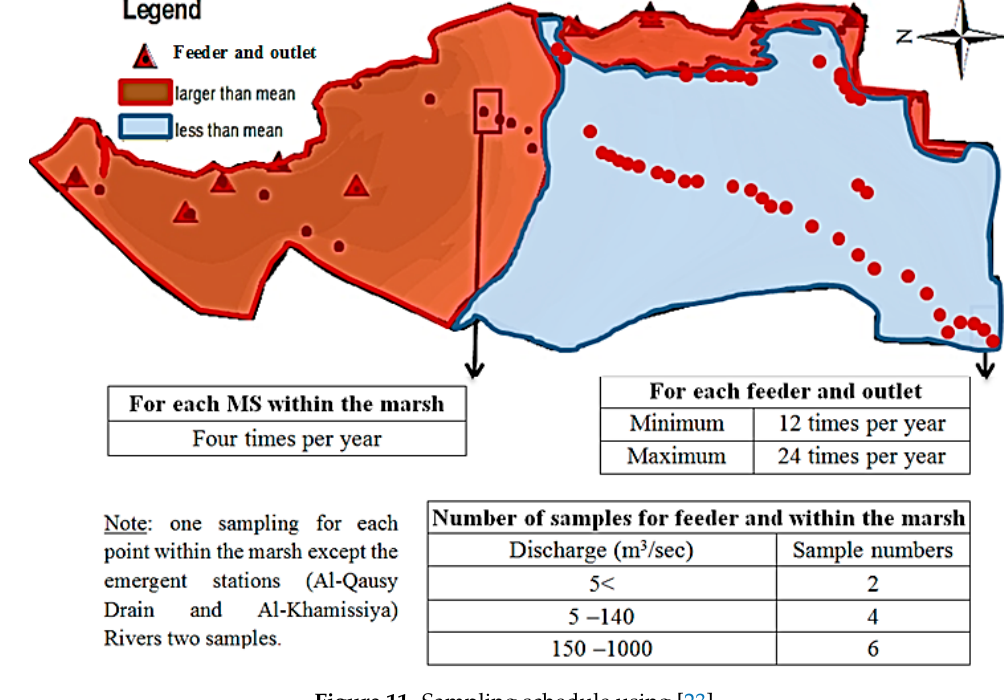
Figure 11. Sampling schedule using Figure 11 . Sampling schedule using [23].